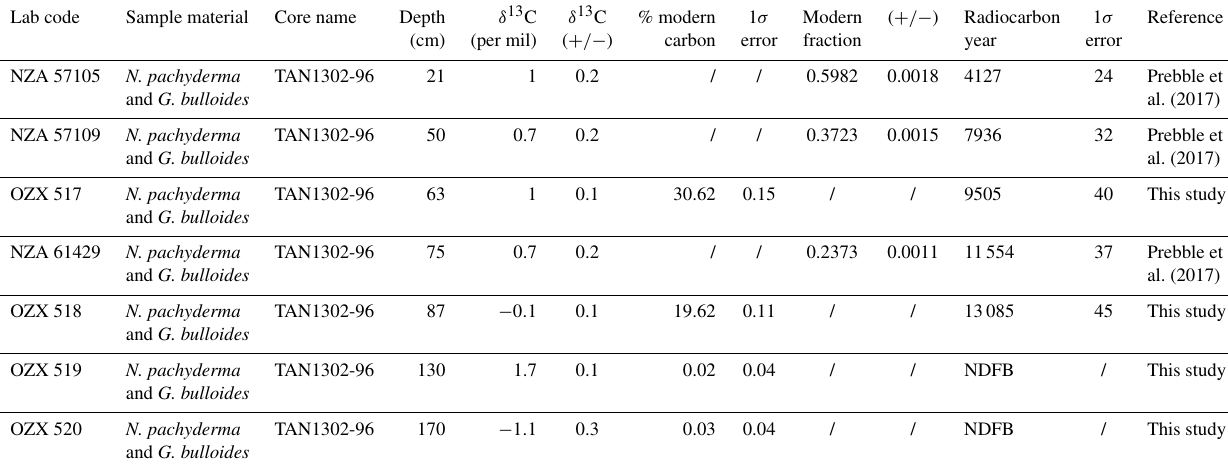
Table A1. Radiocarbon dates taken from TAN1302-96. NDFB = not distinguishable from the background.